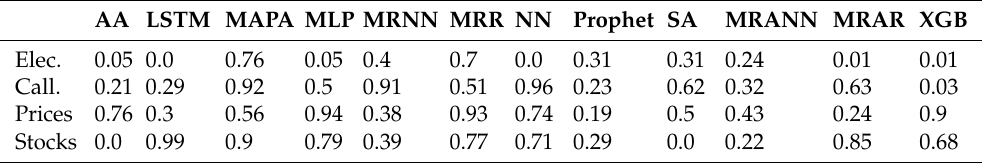
Table A1. The Kolmogorov–Smirnov statistic for testing if the forecast error with MASE follows an F distribution for all datasets and forecasts for horizon = 1.